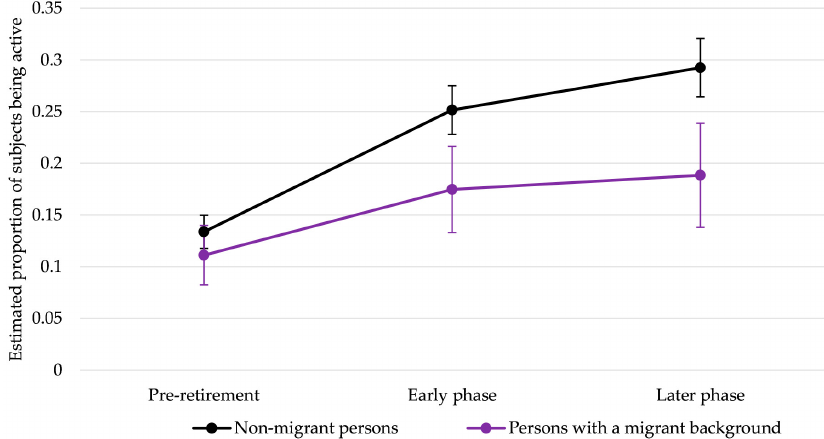
Figure 2. Estimated proportions of subjects participating in sports by retirement status adjusted for sex, age at retirement, SES, health status and BMI (marginal means with 95% CIs).